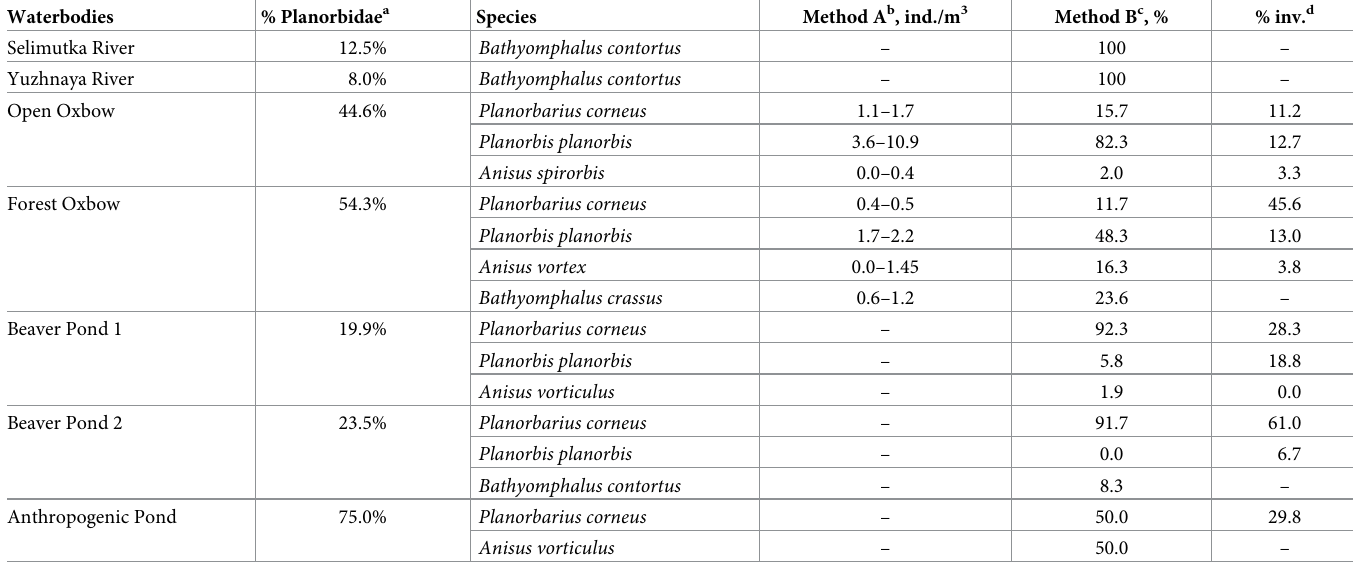
Table 2. Prevalence of planorbid snails in waterbodies